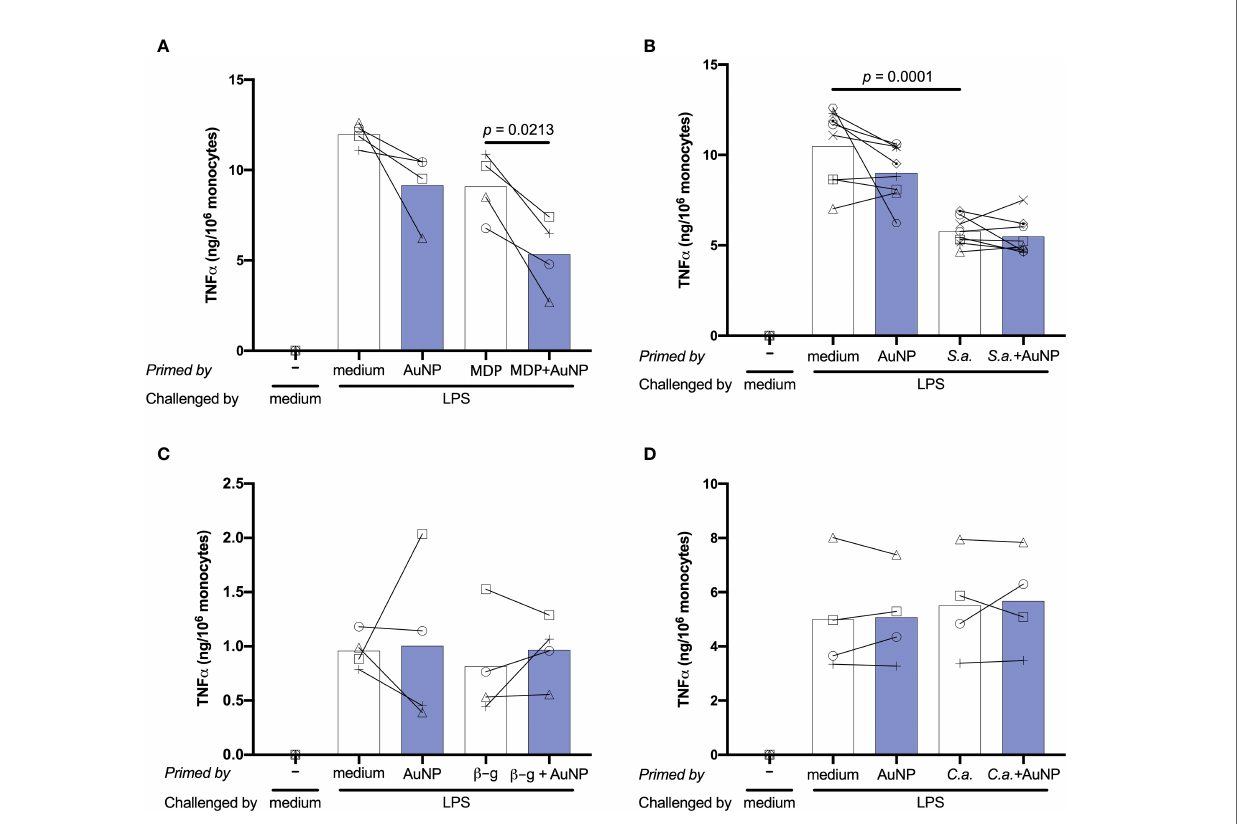
FIGURE 4 | Effect of AuNPs on the memory response of monocytes primed by soluble or particulate microbial stimuli. CD14 + monocytes were primed with MDP (A) , S. aureus (B) , b -glucan (C) or C. albicans (D) for 24 h in the presence or absence of AuNPs (20 µg/mL, indicated by blue bars), then washed and rested for 6 days. Cells were then challenged with LPS (5 ng/mL) for 24 h, and supernatants collected for cytokine measurement. The in fl ammatory response is reported in terms of production of TNF a (ng/10 6 monocytes), and individual donor values are depicted concurrent with mean cytokine production. p values are indicated when < 0.05 for the comparisons between unprimed and primed groups and priming with and without NPs, n = 4 (A, C, D) , n = 8 (B)